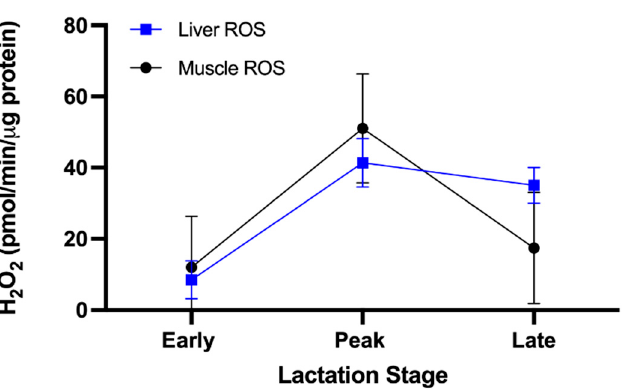
Figure 2. Oxidant emission in liver and skeletal muscle mitochondria across lactation. ROS were quantified from isolated mitochondria at early (8 ± 2 DIM), peak (75 ± 4 DIM), and late (199 ± 6 DIM) lactation from 11 multiparous Holsteins per timepoint. Data are presented as LSMeans ± SE. Liver ROS emissions increased significantly throughout lactation ( p = 0.001).